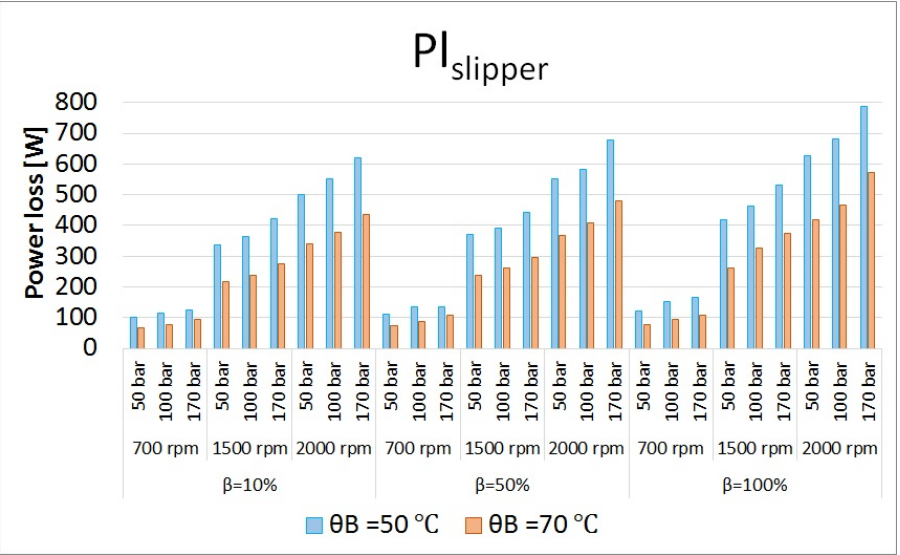
Figure 27. Total power losses in slipper/swash plate interface at different operating conditions.